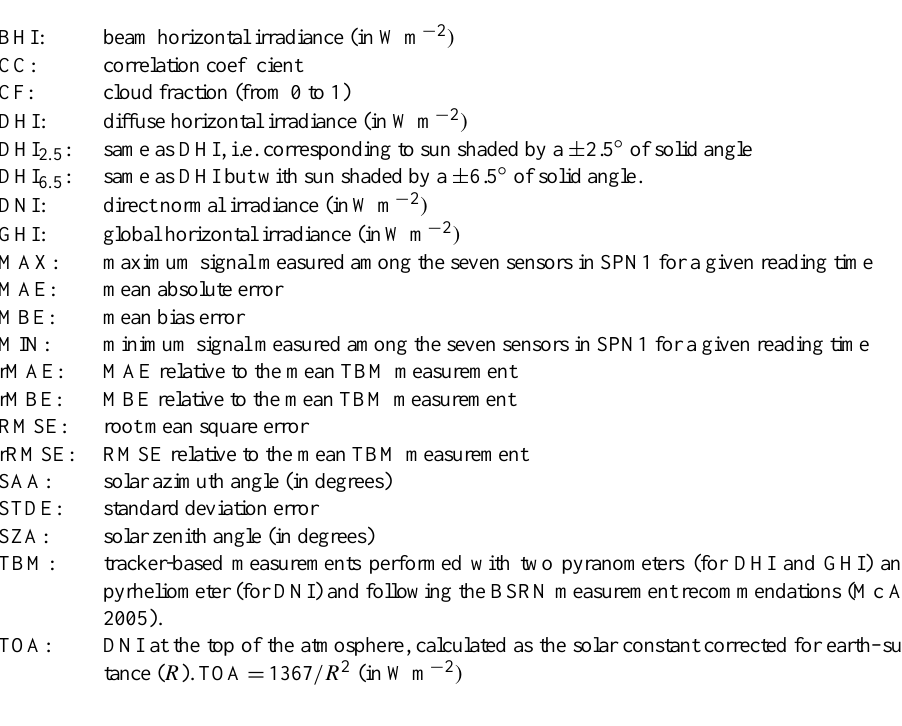
tracker-based measurements performed with two pyranometers (for DHI and GHI) and one pyrheliometer (for DNI) and following the BSRN measurement recommendations (Mc Arthur,